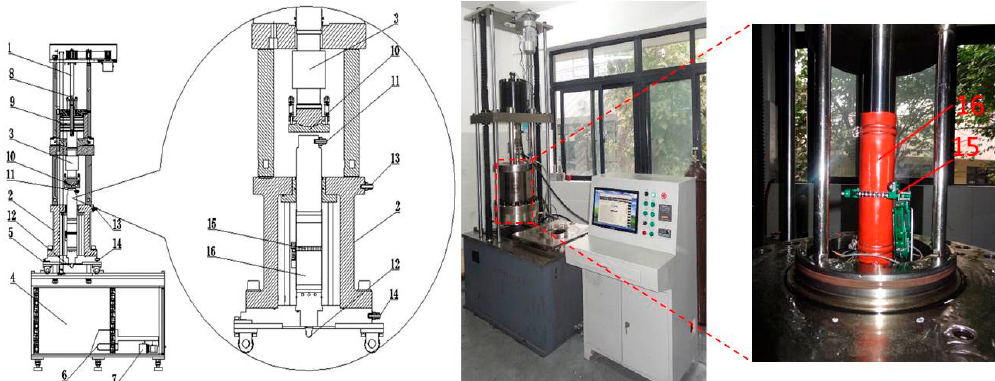
Figure 1. The scheme of experimental system [33,34]. 1—Lifter, 2—Pressure vessel, 3—Sensor of axial